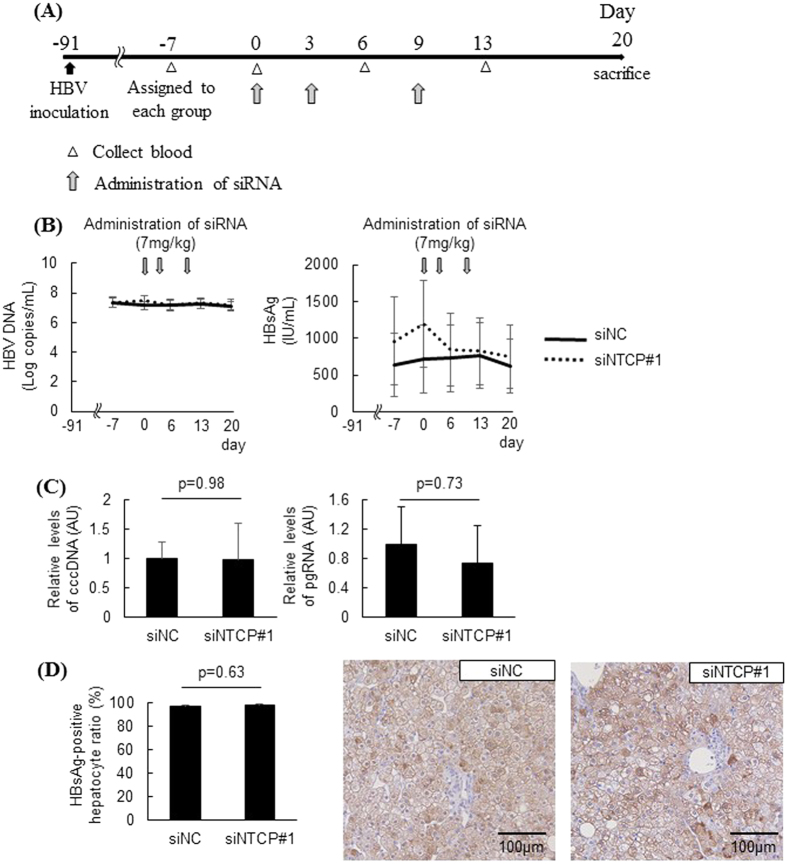
NTCP inhibition in HBV-infected chimeric mice did not affect HBV infection.HBV-infected humanized -liver chimeric mice were treated with siRNA against human-specific NTCP 13 weeks after inoculation (n = 5). (A) Schematic of experimental procedure. (B) Serum HBV DNA and HBsAg levels. (C) Liver cccDNA and pgRNA levels 20 days after the first siRNA administration. (D) Representative images of HBsAg immunohistochemical analysis 20 days after the first siRNA administration and the ratio of HBsAg-positive cells (n = 5). AU; arbitrary unit.